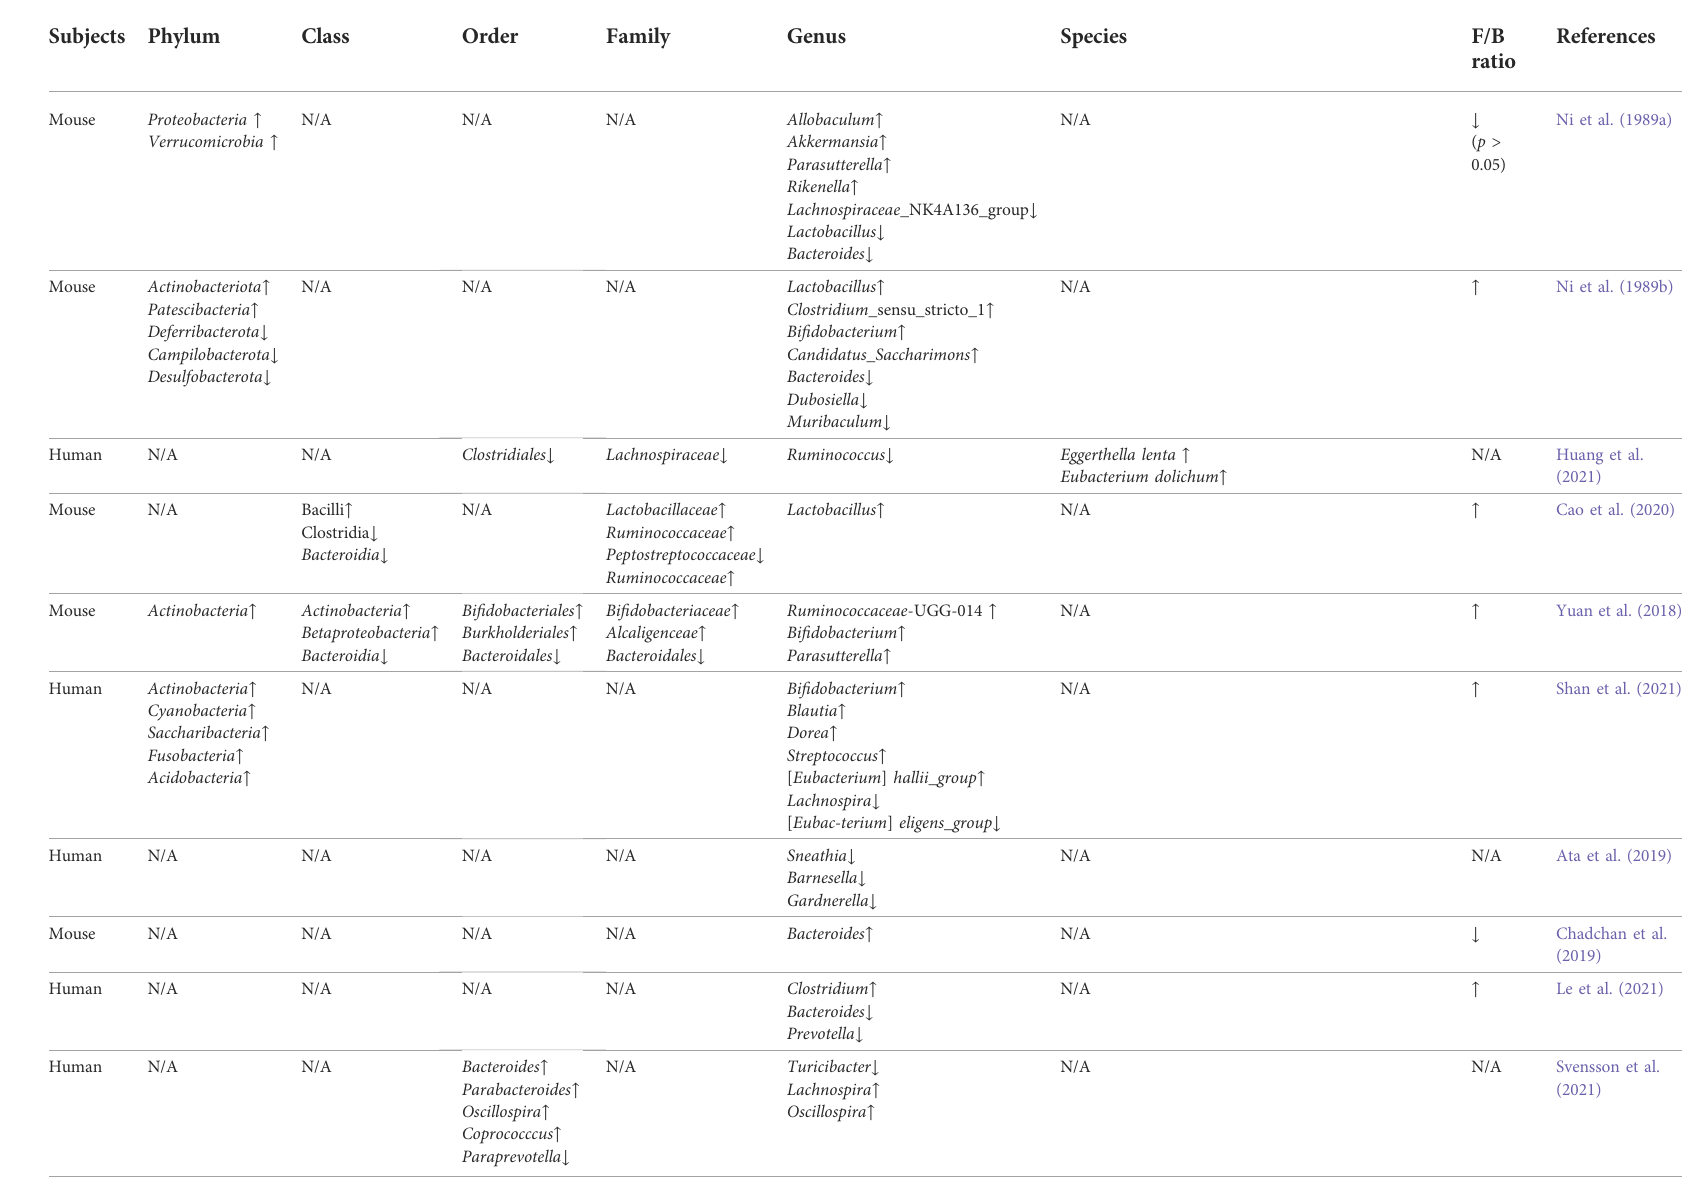
TABLE 1 The GM in EMS